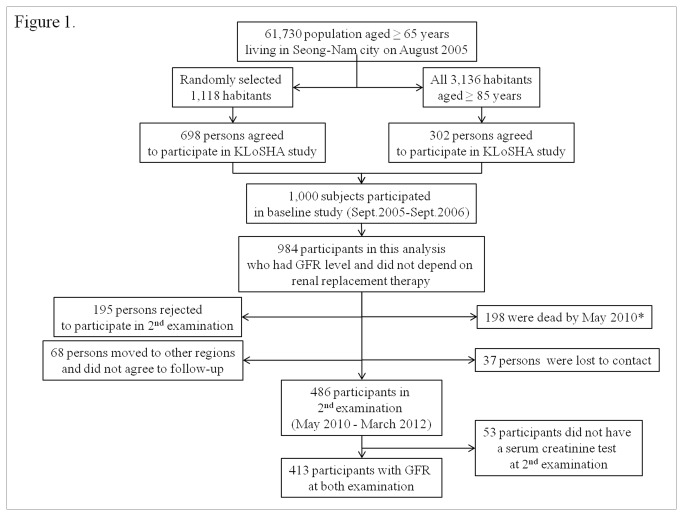
The participants in this study from the KLoSHA cohort.